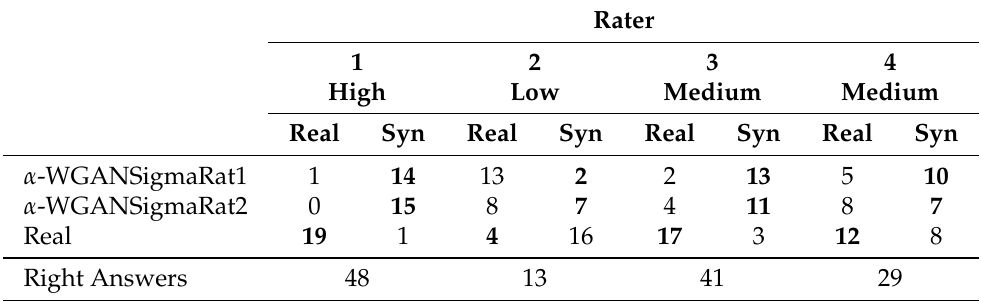
Table 3. Turing test results. The first two rows are the classification results of the scans generated by the α -WGANSigmaRat1 and α -WGANSigmaRat2 models, respectively, the third row is the classifica- tion results of the real scans, and in the last row are the number of right classifications. Syn are the Synthetic scans. The correct answers are in